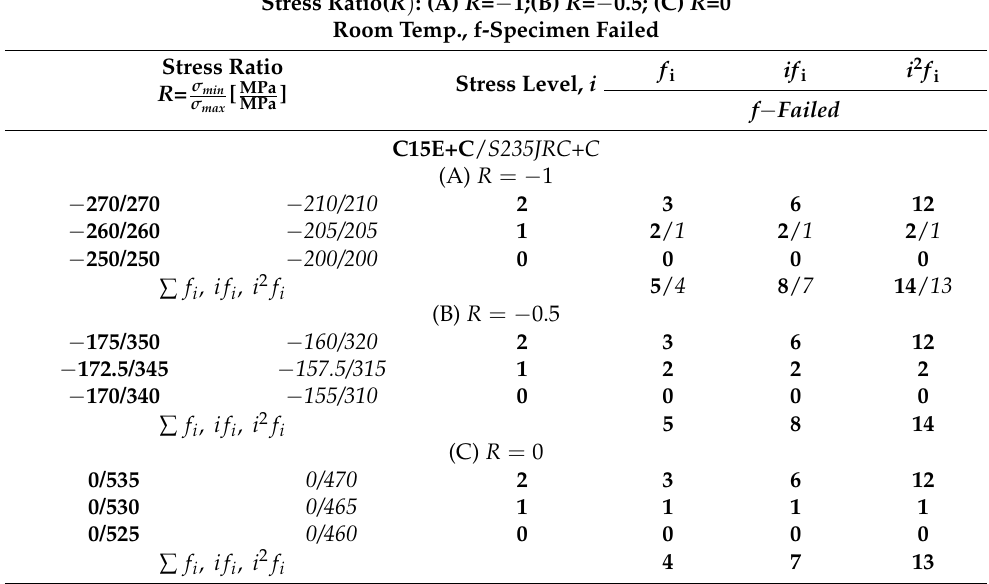
Table 3. Data analysis related to Table 2.